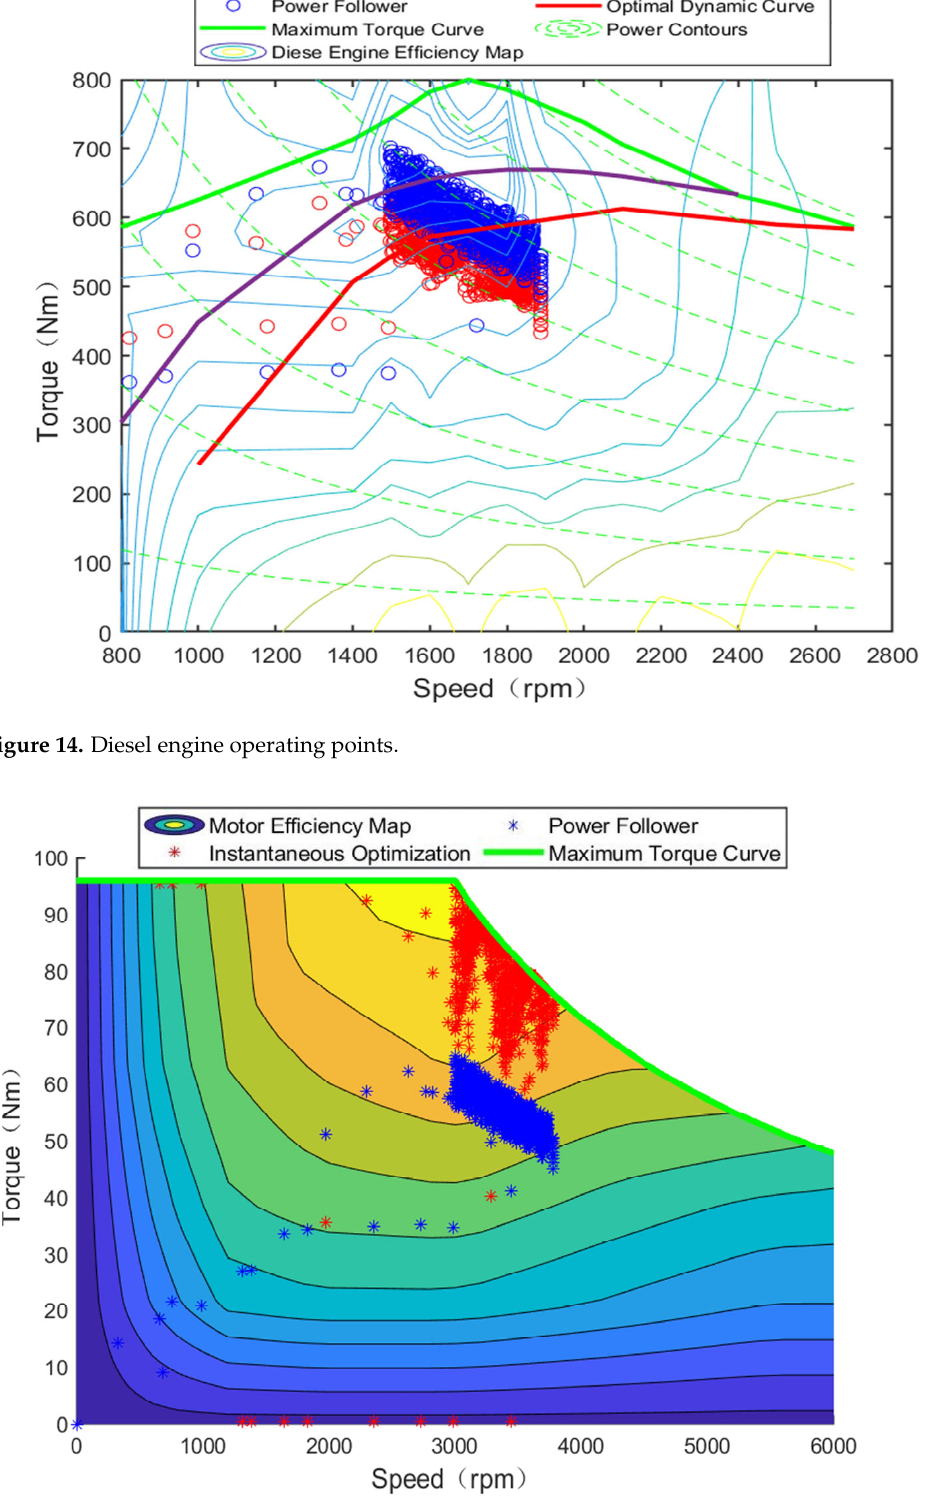
Figure 15. Motor operating points.